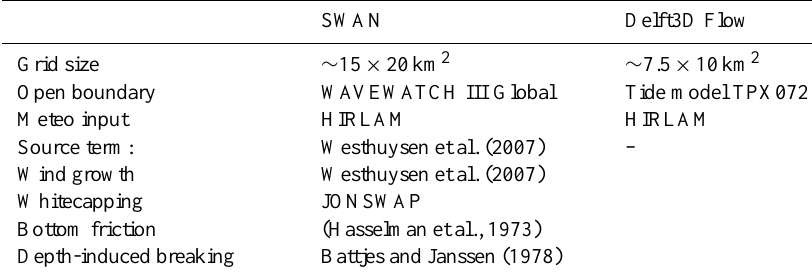
Table 2. Model set-up for DCSM